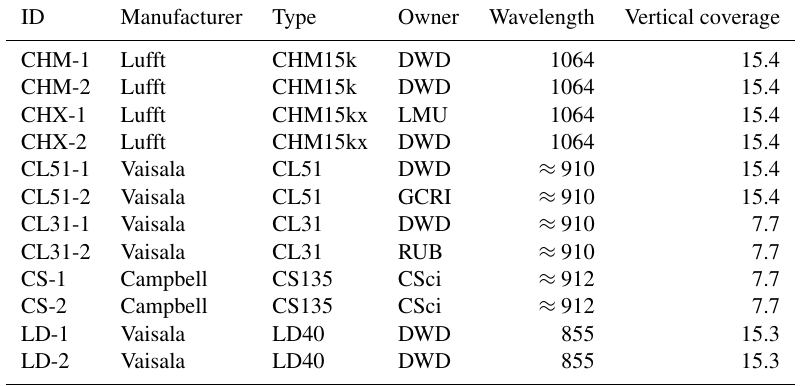
Table 1. List of deployed ceilometers in CeiLinEx2015: providers are DWD (German Weather Service), LMU (Ludwig Maximilian Univer- sity of Munich), RUB (Ruhr-University Bochum), GCRI (Global Change Research Institute) and CSci (Campbell Scientific, manufacturer of the instruments). The emitted wavelength is given in nanometers, the vertical coverage in kilometers. ID Manufacturer Type Owner Wavelength Vertical coverage CHM-1 Lufft CHM15k CHM-2 Lufft